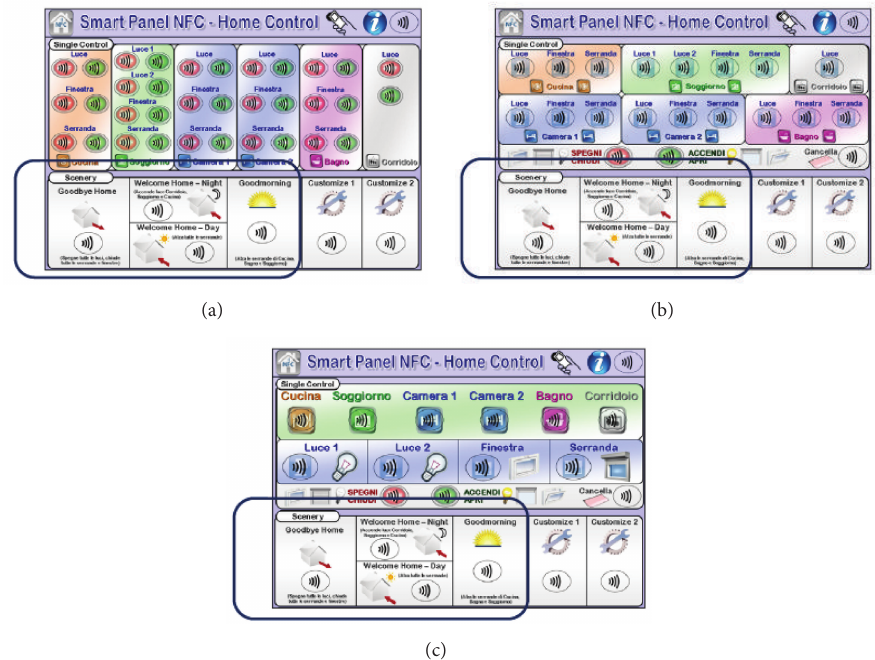
Figure 11: Three versions for the Smart Panel: (a) 1P, (b) 2P, and (c) 3P. The framed areas show the common scenery-commands section of the